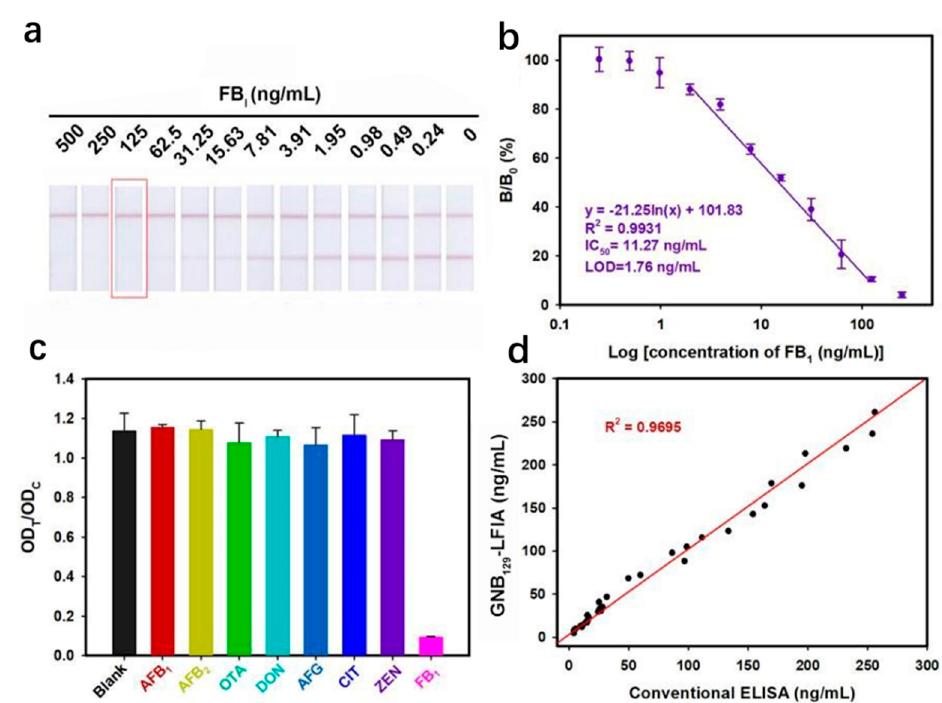
Figure 4. The performance evaluation for the GNB 129 -LFIA strips for FB 1 detection in corn sample. ( a ) The prototypes of GNB 129 -LFIA strips responding to varying FB 1 concentrations in real corn sample detection. ( b ) The competitive inhibition curve of the GNB 129 -LFIA constructed by plotting the B/B 0 × 100% against the logarithm of FB 1 concentration. ( c ) The selectivity of our method by detecting the response against other common mycotoxins. ( d ) The correlation analysis of the detection results between the GNB 129 -LFIA strip and the ELISA method in 35 real corn samples, with FB 1 concentrations ranged from 1.5 to 267 ng/mL. Table 1. The accuracy and precision of the GNB 129 -LFIA method for FB 1 detection in spiked corn samples. Spiked